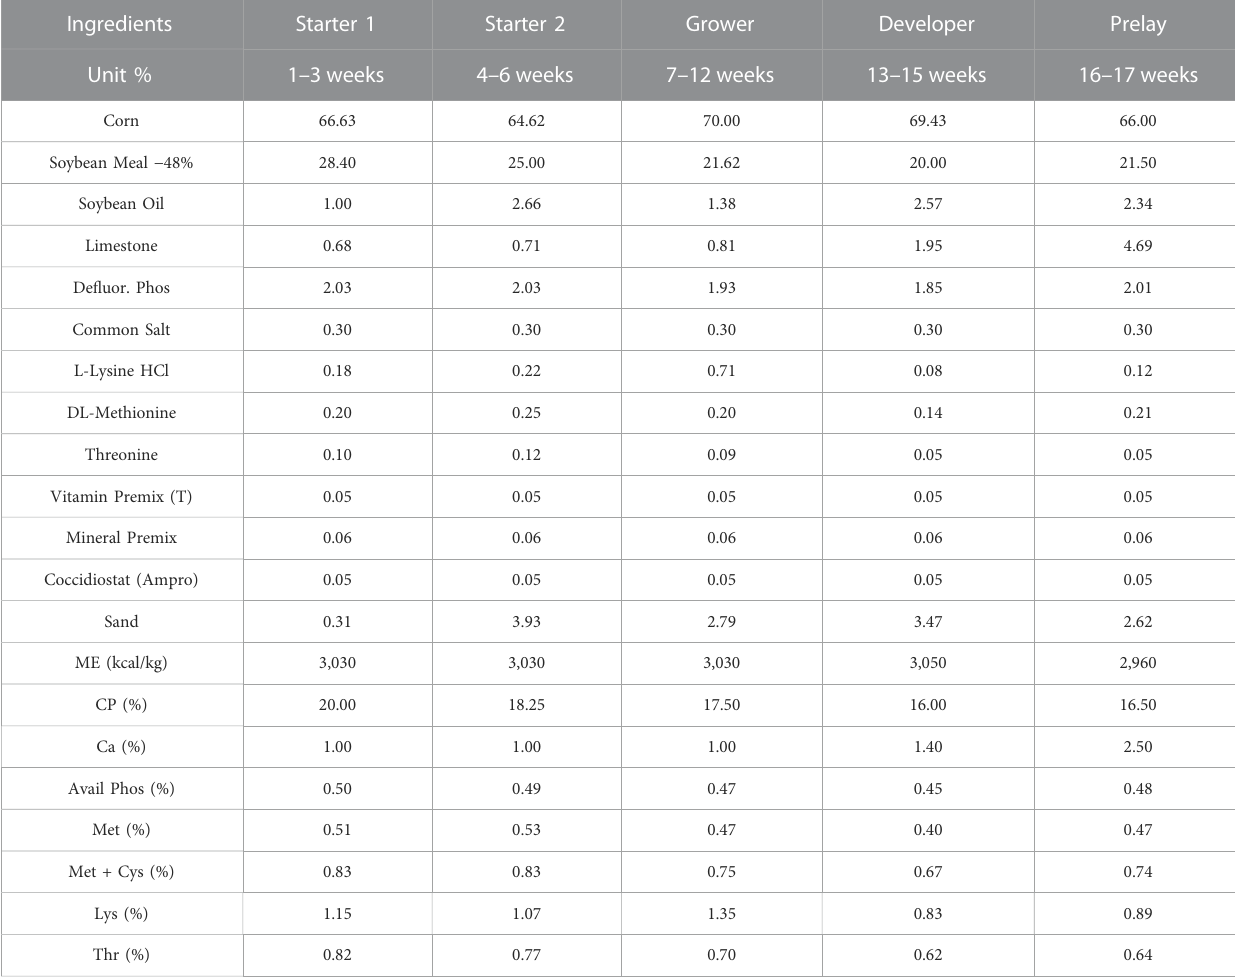
TABLE 1 Ingredients and diet composition for treatments D and H25D of the control diets fed to pullets at different stages for 17 weeks. Ingredients Starter 1